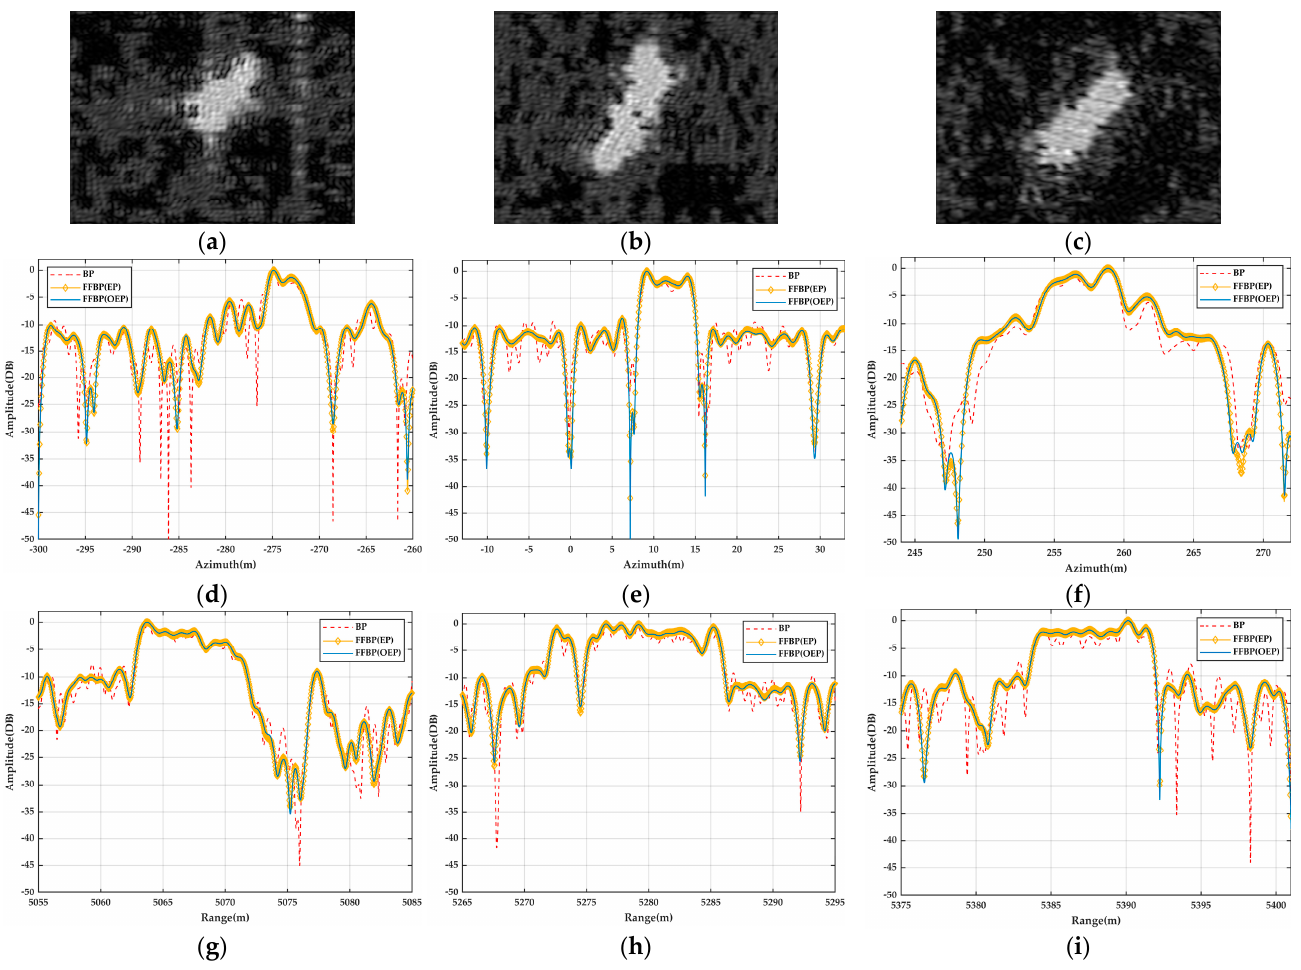
Figure 15. The selected ship targets and their pro fi les of the imaging results obtained by the di ff erent algorithms. ( a ) Ship target A; ( b ) Ship target B; ( c ) Ship target C; ( d ) Azimuthal pro fi le of the ship target A; ( e ) Azimuthal pro fi le of the ship target B; ( f ) Azimuthal pro fi le of the ship target C; ( g ) Range pro fi le of the ship target A; ( h ) Range pro fi le of the ship target B; ( i ) Range pro fi le of the ship target C.